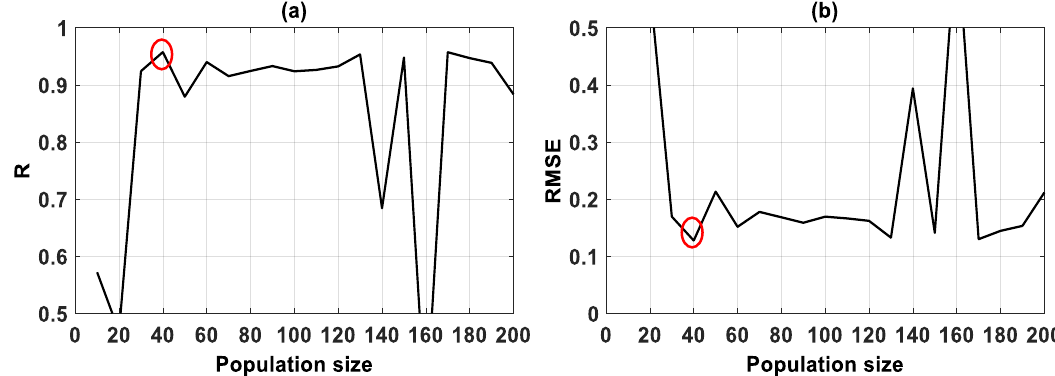
Figure 1. Optimization of population size with respect to ( a ) Correlation Coefficient (R) and ( b ) Root Mean Squared Error (RMSE). Appl. Sci. 2019 , 9 , x FOR PEER REVIEW